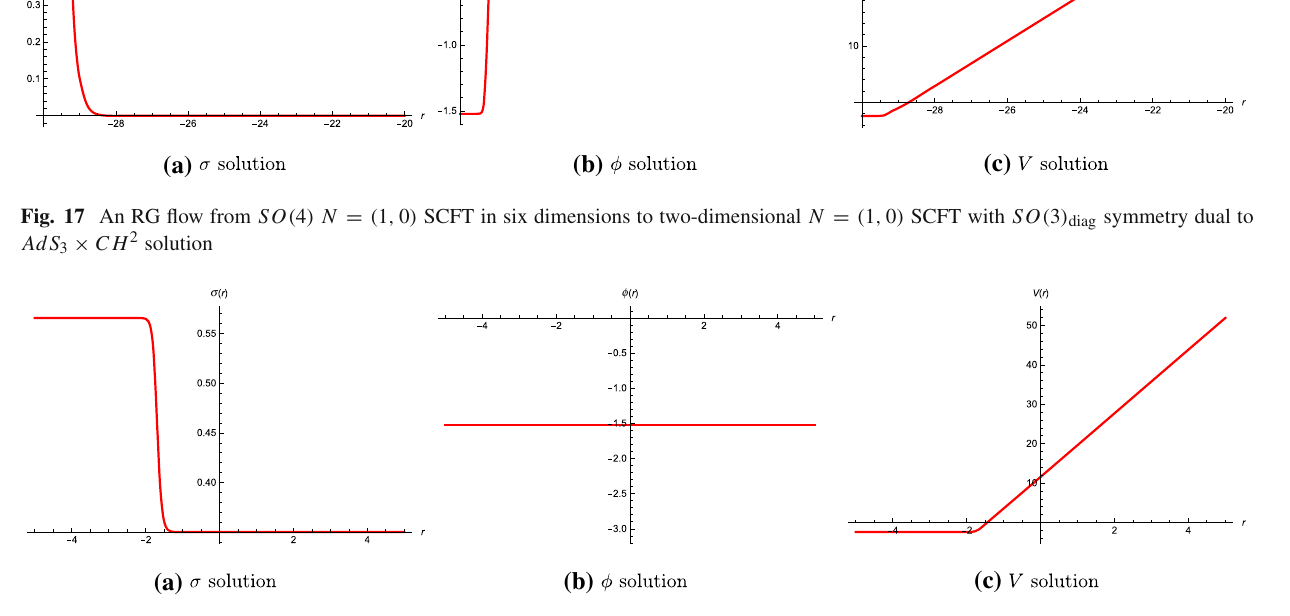
Fig. 18 An RG flow from SO ( 3 ) N = ( 1 , 0 ) SCFT in six dimensions to two-dimensional N = ( 1 , 0 ) SCFT with SO ( 3 ) diag symmetry dual to